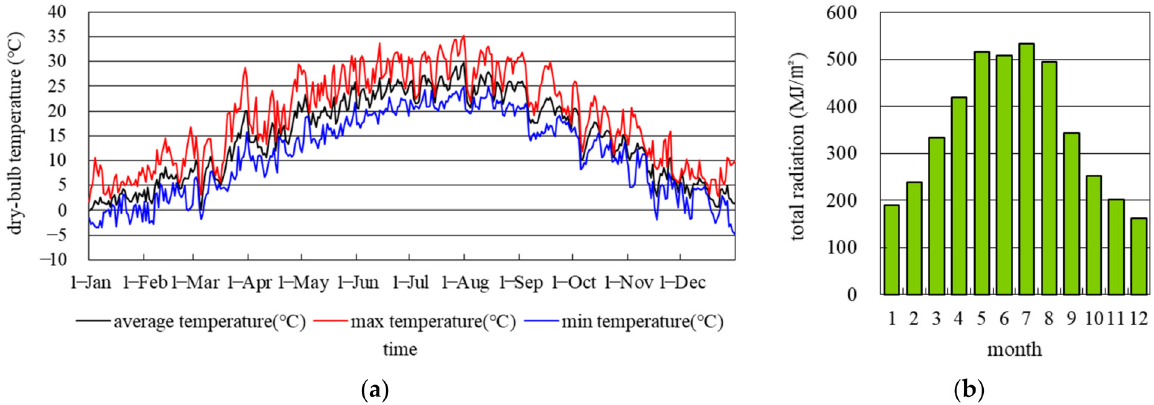
Figure 4. The typical year meteorological data of Hanzhong: ( a ) daily dry-bulb temperature; ( b ) monthly total solar radiation.